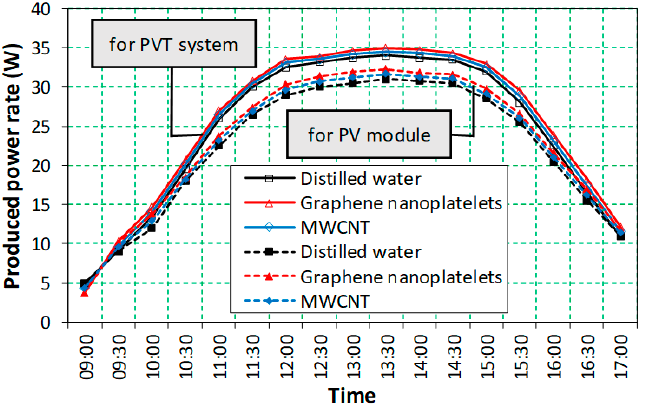
Figure 6. Change in the electrical power rate produced by PV as a module and a